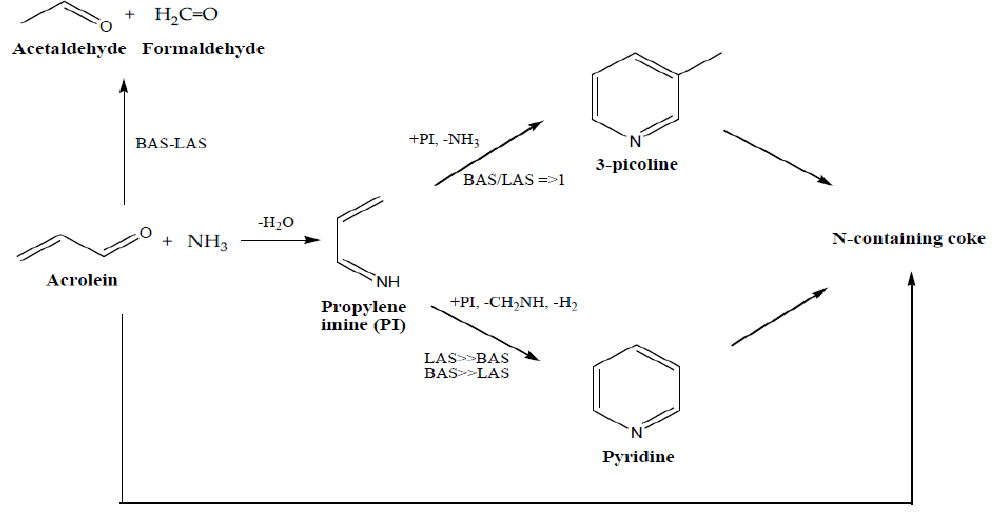
Figure 16. Reaction routes for acrolein and ammonia over the Y ‒ type zeolites.